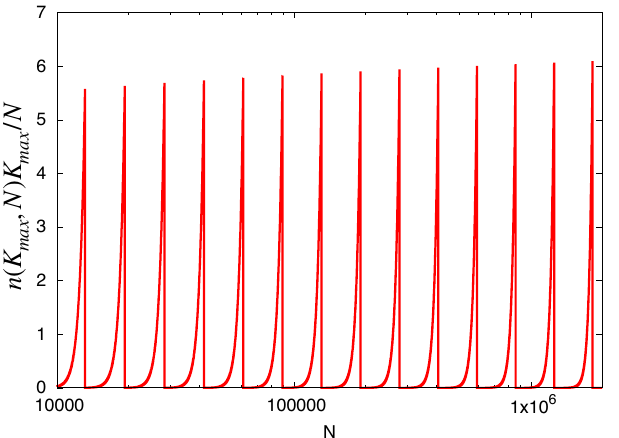
Figure 3. Expected number of maximum cliques of size K max per site in the graph, as a function of N.